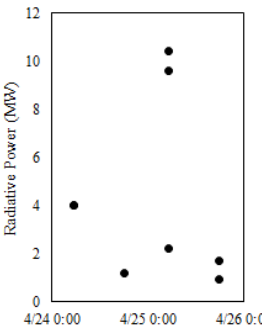
Figure 4 . Radiative power (MW) of fire pixels detected in Benguet, Philippines by VIIRS.